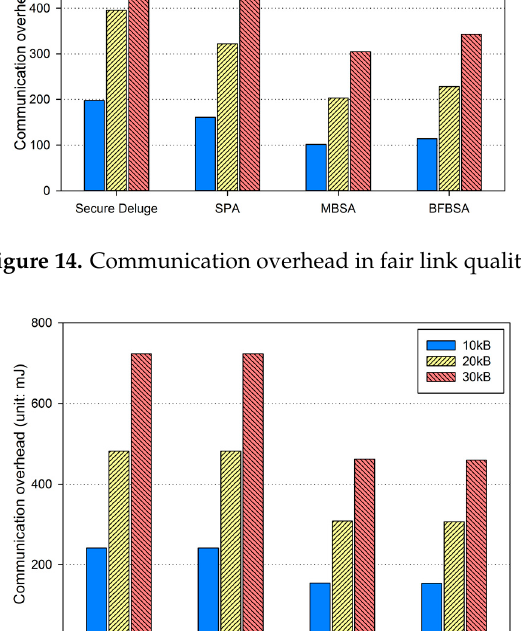
Figure 15. Communication overhead in bad link quality.